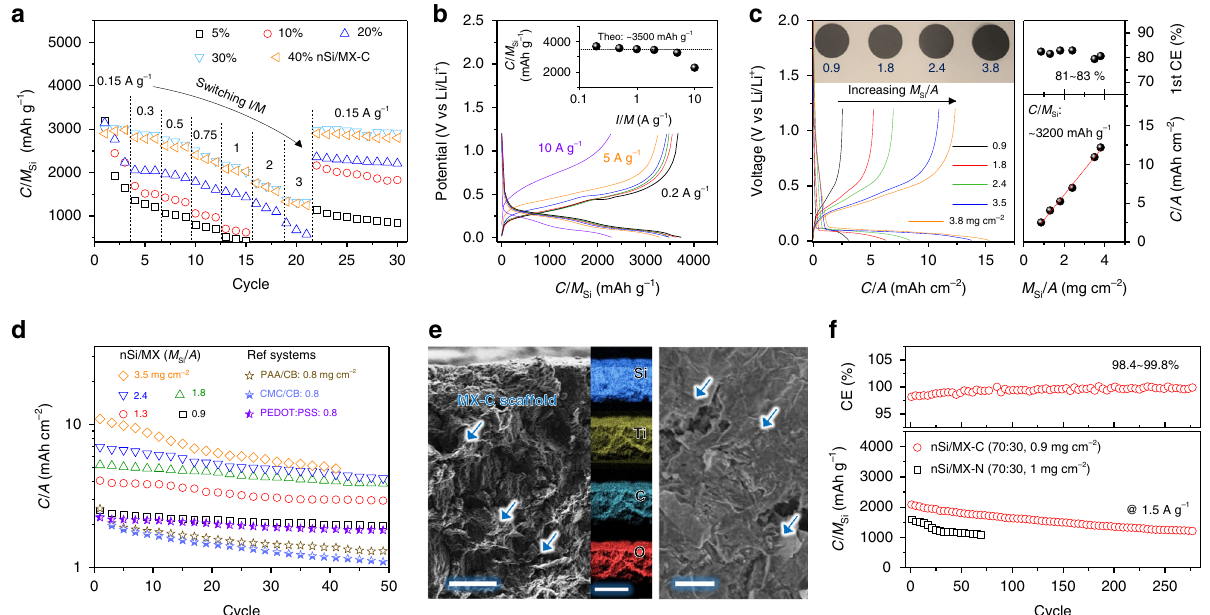
Fig. 4 Electrochemical characterization of nSi/MXene anodes. a Rate performance comparison for nSi/MX-C electrodes with various MX-C mass fractions. Note that the capacity values are normalized to the mass of silicon ( C / M si ). b Asymmetric charge-discharge curves of the typical nSi/MX-C electrode. Inset is the as-obtained C / M Si at various delithiation rates. c Left: fi rst cycle charge-discharge curves at a 0.15 A g − 1 (~1/20 C-rate) of the nSi/MX-C electrodes (MX-C M f = 30 wt%) with the M Si / A ranging from 0.9 to 3.8 mg cm − 2 . Insets are the optical images of these electrodes. Right: fi rst Coulombic ef fi ciency (top) and areal capacity (bottom) of nSi/MX-C (MX-C M f = 30 wt%) with various M Si / A . The line slope indicates the average C / M Si (~3200 mAh g − 1 ) achieved in various electrodes. d Cycling performance comparison among the electrodes with various M Si / A . Also included are the control samples made with PAA/carbon black (CB), CMC/CB, poly(3,4-ethylenedioxythiophene):poly(styrenesulfonic acid) (PEDOT:PSS) as the aqueous binder and conductive agent, respectively. e Cross-sectional (left, scale bar = 10 µ m) and top-view (right, scale bar = 1 µ m) scanning electron microscopy images of nSi/MX-C (MX-C M f = 30 wt%, M Si / A = 2.4 mg cm − 2 ) after cycling; also included is the energy-dispersive X-ray mapping, showing a uniform distribution of nSi and MX-C in the cycled electrode (scale bar = 50 µ m). f Lifetime of nSi/MX-C and nSi/MX-N (MXene M f = 30 wt%) electrodes at a low M A (0.9 – 1 mg cm − 2 ) and a high rate (1.5 A g − 1 ). Also included is the Coulombic ef fi ciency of nSi/MX-C Si /